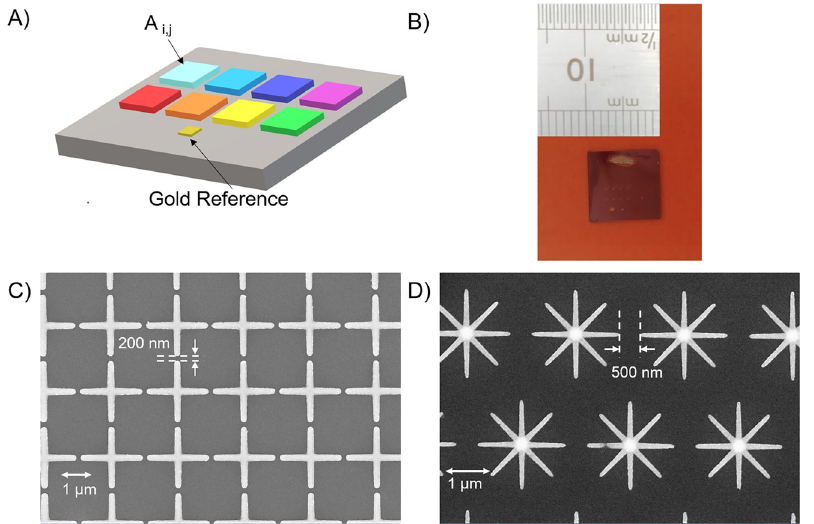
Figure 3: (A) Schematic of the pixeled metasurface. (B) Photograph of a typical 1 cm 2 chip fabricated. (C), (D) Representative SEM images of CS-type (CS 2,4 , with L = 2.3 µm, P = 2.5 µm, W = 200 nm) and SS-type (SS 2,4 , with L=2.0µm,P=2.5µm,W=110nm)designs, respectively. The arrows indicate the mini- mum gap between adjacent